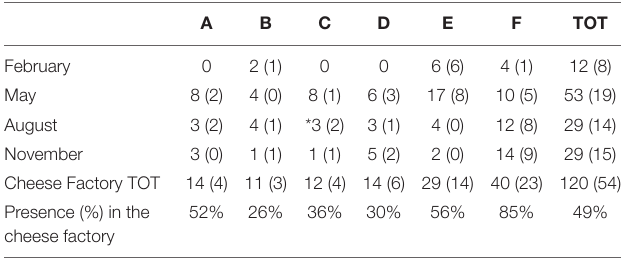
TABLE 6 | Distribution of phage isolates (n ◦ Is.) from NWS samples collected from six dairy factories labeled from A to F, four times a year from February to November